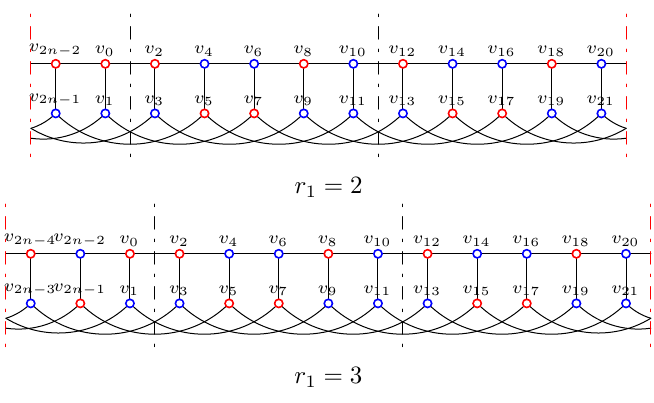
Figure 10. Segments of f in Case 1.1.2 in Lemma 8.